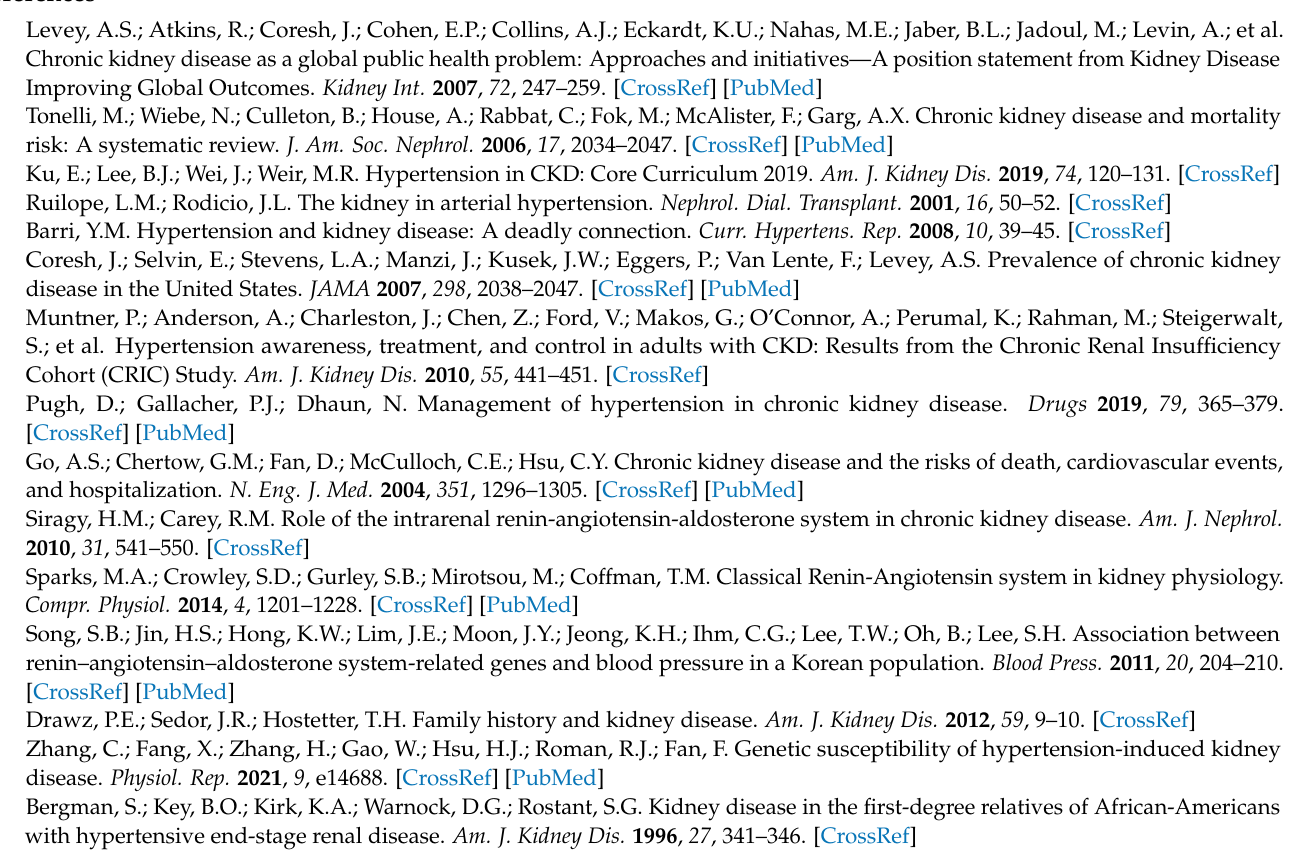
Haploview version 4.1. Figure S2: Regional association plots for the 4q28.3 ( A ) and 13q12.11 ( B ) regions. The statistical significance ( − log 10 p -value) of the SNPs for the association results with HKD at the combination phase is plotted. The colors show the linkage disequilibrium ( r 2 ) between the top SNP marked with purple diamond and the remaining SNPs. The genetic recombination rates are shown by a blue line. Plots were generated by the LocusZoom website (http://csg.sph. umich.edu/locuszoom/, accessed on 10 May 2021). Table S1: Genetic variants associated with hypertensive kidney disease in discovery phase. Table S2: Results of an association analysis between SNPs in the PRPF39 , FKBP3 and FANCM genes and hypertensive kidney disease and hypertensive nephropathy-related